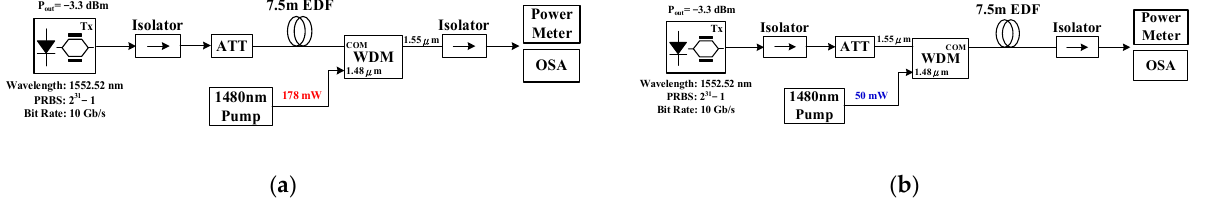
Figure 12. Experimental setup for the EDFA in ROA 3 : ( a ) backward-pumping configuration and ( b ) forward-pumping configuration.